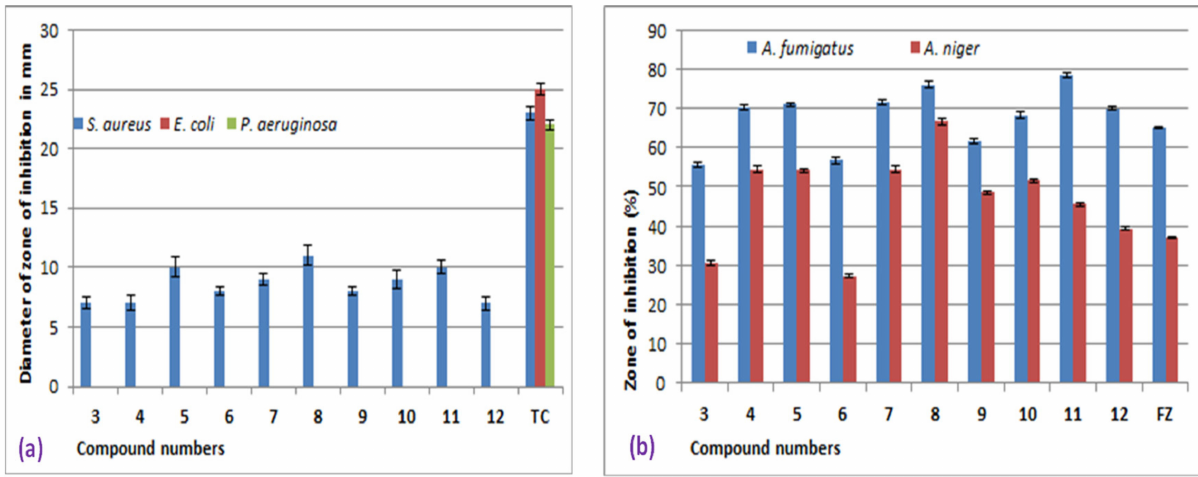
Figure 4. ( a ) Diameter of zone of inhibition in mm against bacteria (TC = tetracycline), ( b ) % of inhibition against fungal pathogens (FZ = fluconazole). Table 4. Zone of inhibition (%) against fungal pathogens by SEs 4 – 12 . Percentage of Zone of Inhibition